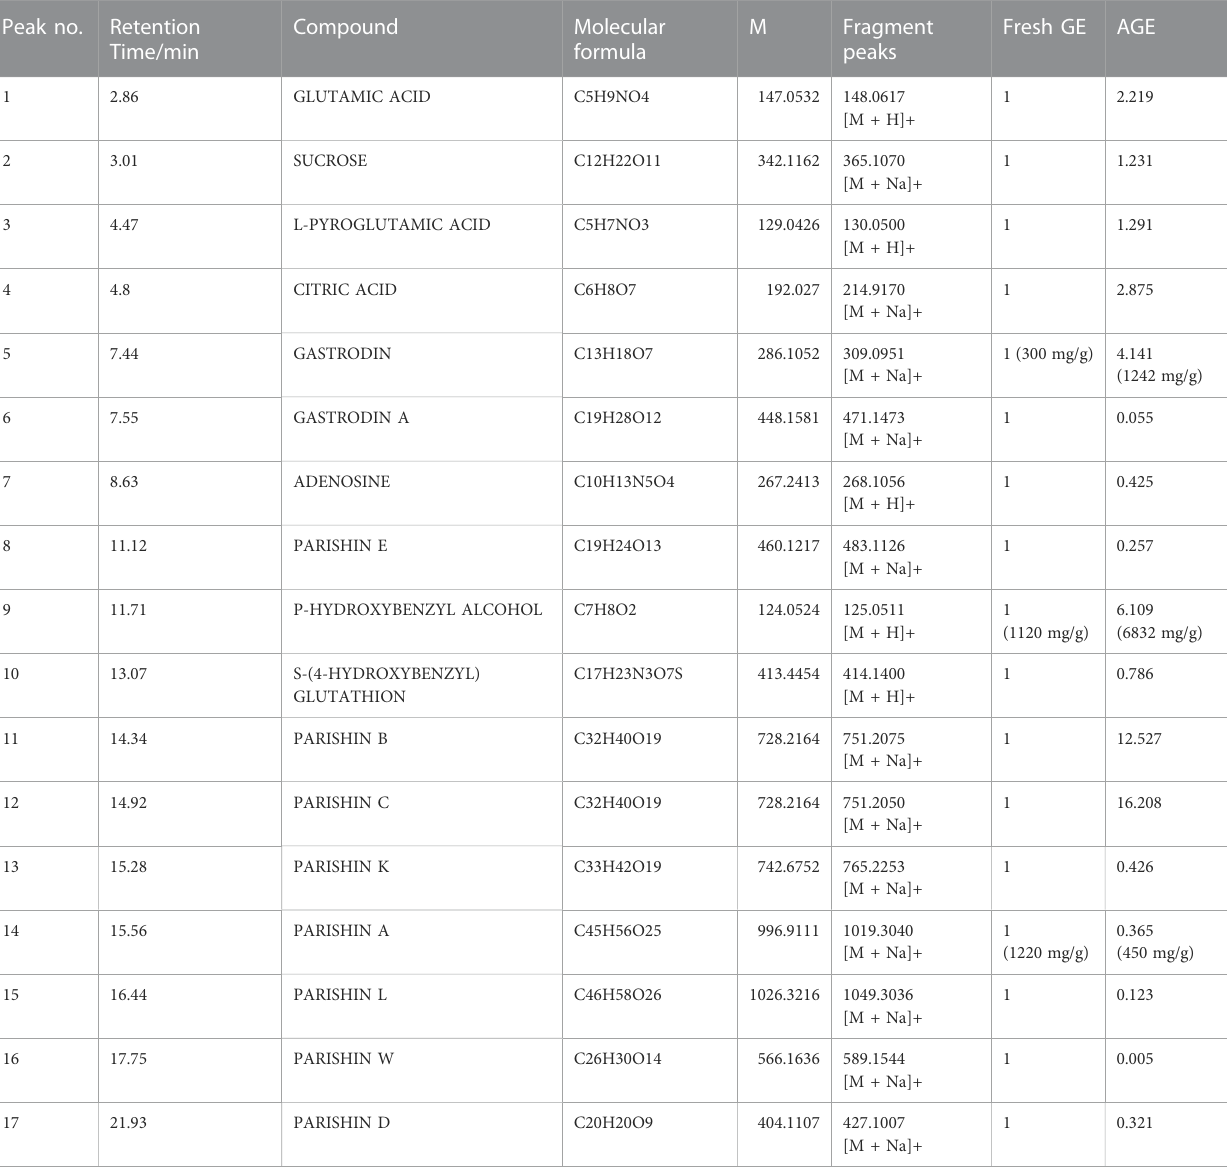
TABLE 1 The relative contents of 17 active ingredients in fresh GE and AGE samples. Peak